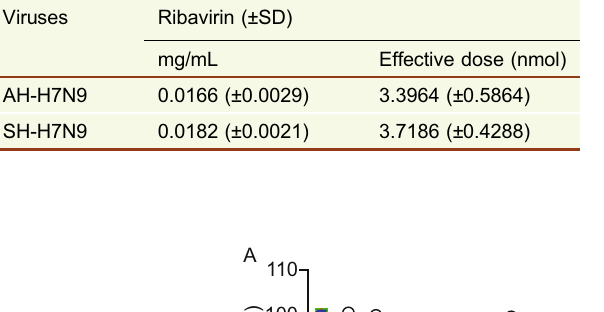
cant ( P > 0.5) (Fig. 1C).